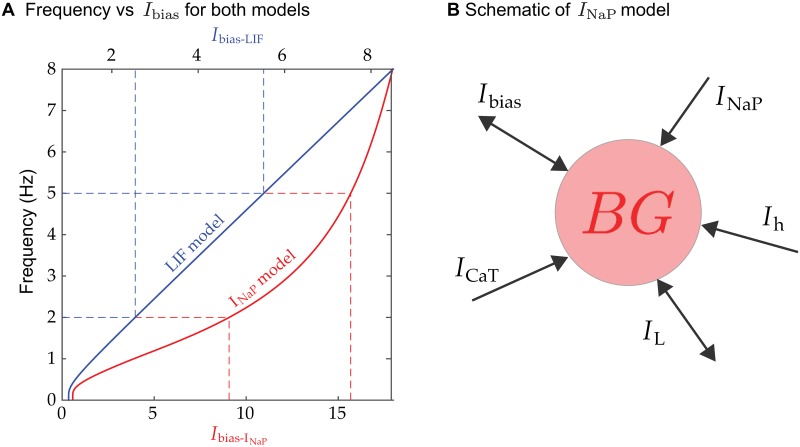
Biophysical models.A. Frequency vs. Ibias curves for LIF (blue) and INaP (red) models. Observe the different scales for the upper and lower horizontal axes. Dashed lines show the corresponding Ibias values for two different frequencies. Both curves are increasing, starting from zero frequency, which yields qualitatively similar behavior from either model. While the LIF relation is almost linear for frequencies larger than 1 Hz, the INaP relation is more power-like, with a steeper gradient from 3 to 8 Hz, this yields differences in the quantitative behavior of the models. B. Schematic of INaP neuron with the different ionic currents that contribute to its excitability and spiking behavior.